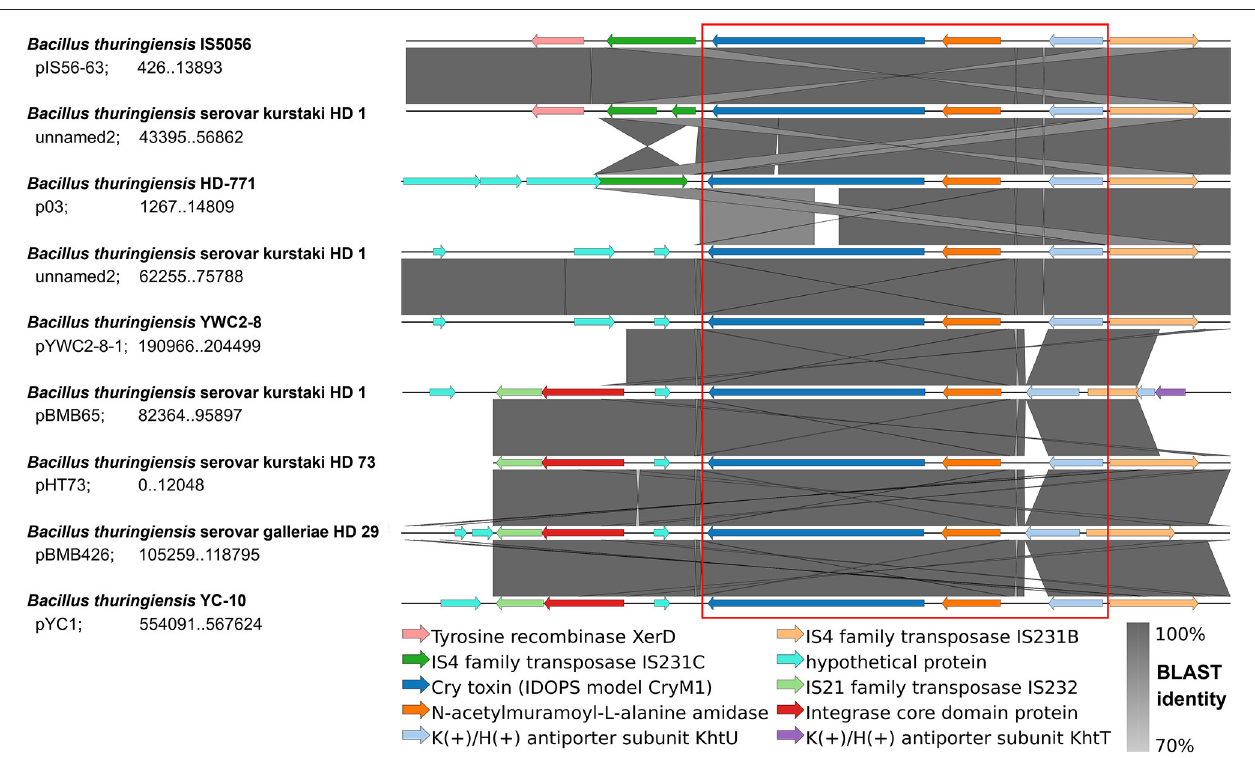
FIGURE 2 | IDOPS genetic environment comparison. IDOPS retrieved, annotated, and aligned the genetic region surrounding cry1 genes reported as a cassette within Bt plasmids by Fiedoruk et al. (2017). The visualization is generated by EasyFig as implemented internally in IDOPS. The reported cry1 cassette is marked in red. Strain names, plasmid, and coordinates appear next to each